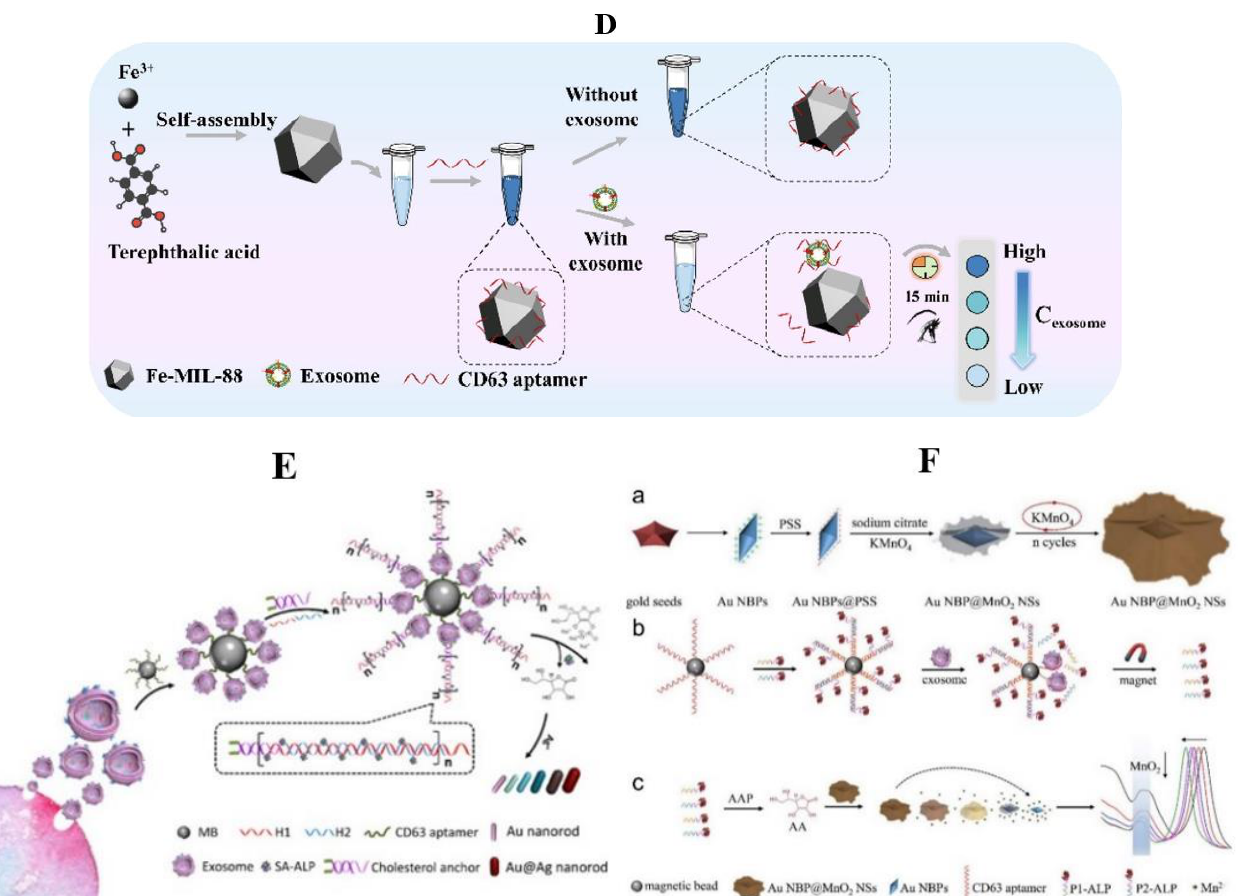
Figure 2. Detection of exosomes in breast cancer by the colorimetric method (nanomaterials). ( A ) illustration of DNA aptamer accelerating the intrinsic peroxidase-like activity of g–C 3 N 4 NSs for the detection of exosomes [73]; ( B ) schematic representation of the detection mechanism of the proposed method for exosomes [74]; ( C ) schematic representation of the mechanism for label-free detection of exosomes based on CD63 aptamer inhibiting oxidase activity of CuCo 2 O 4 nanorods [75]; ( D ) illustration of CD63-aptamer-functionalized Fe–MIL-88 for the detection of exosomes [79]; ( E ) schematic illustration of the mechanism for multicolor visual detection of exosomes based on HCR and enzyme-catalyzed metallization of AuNRs [81]; ( F ) (a) schematic of the fabrication process